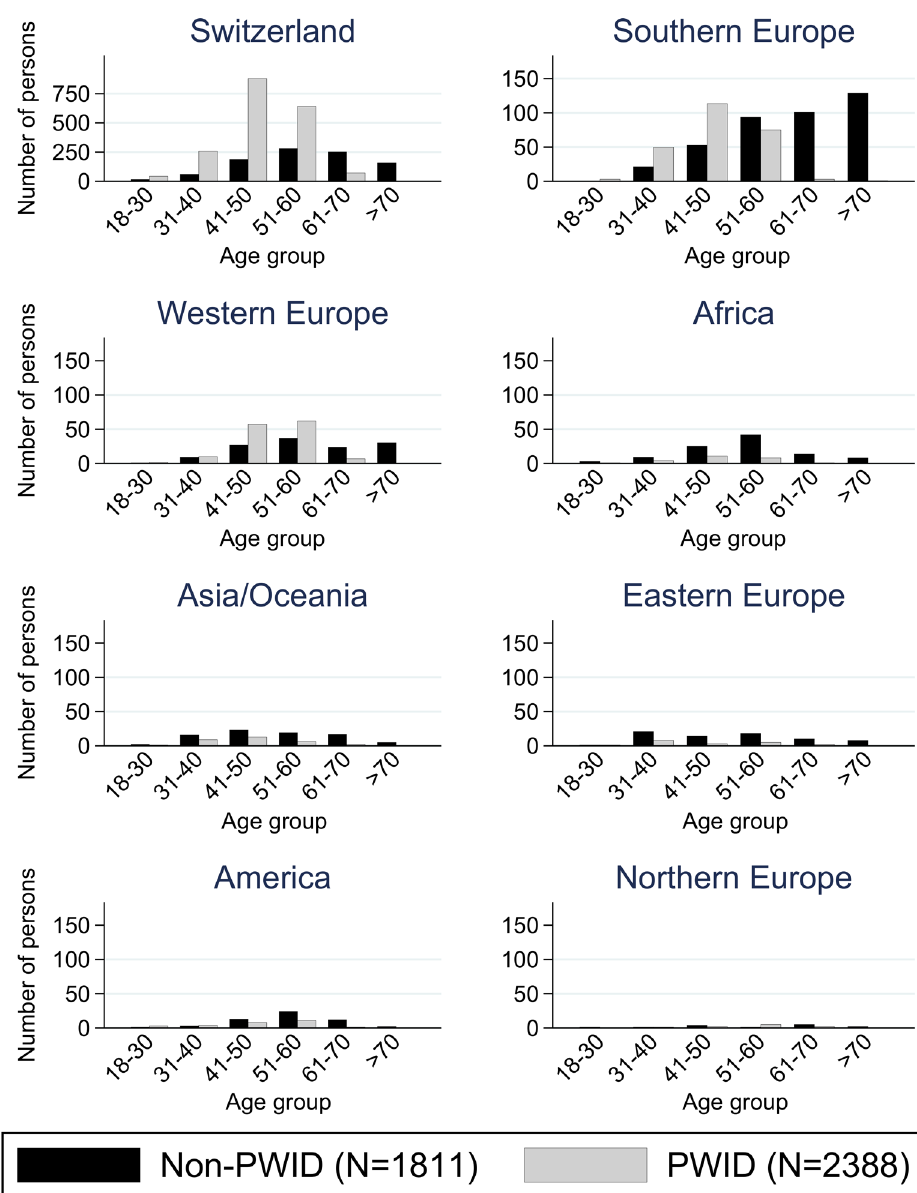
Fig 1. Persons who do not inject drugs (non-PWID) versus persons who inject drugs (PWID) in the Swiss Hepatitis C Cohort Study by region of birth and age (please note the different y-axis scale for